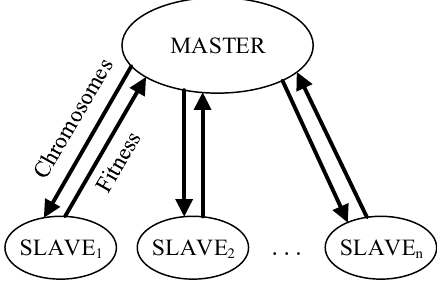
Figure 1. The distributed framework of the distributed genetic algorithm (DGA).